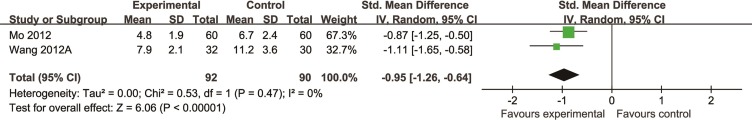
The forest plot: effects of Chinese herbal medicine for reducing hypersensitive C-reactive protein.